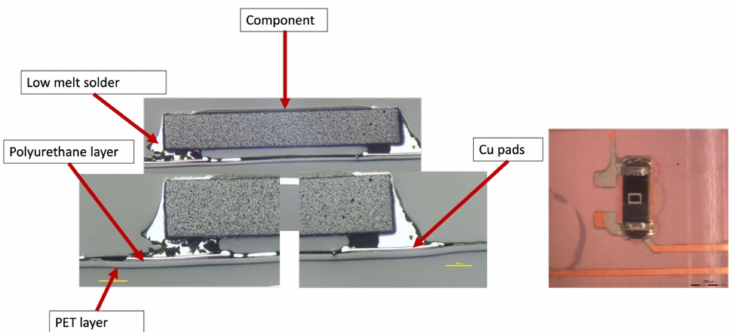
Figure 37. Cross-sectional images at 500 µ m for component C7 ( Left ). Top view of the component at 2000 µ m ( Right